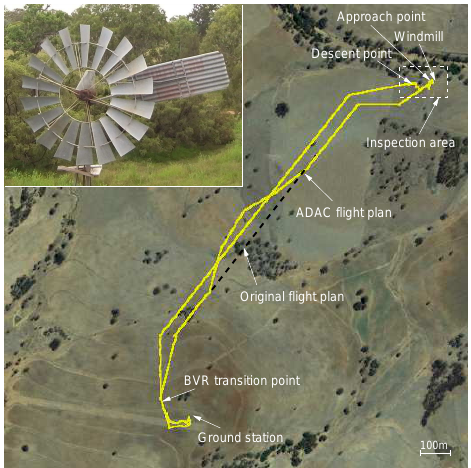
Figure 6: Helicopter trajectory of a BVR windmill inspection mission and zoomed inspection image taken by the